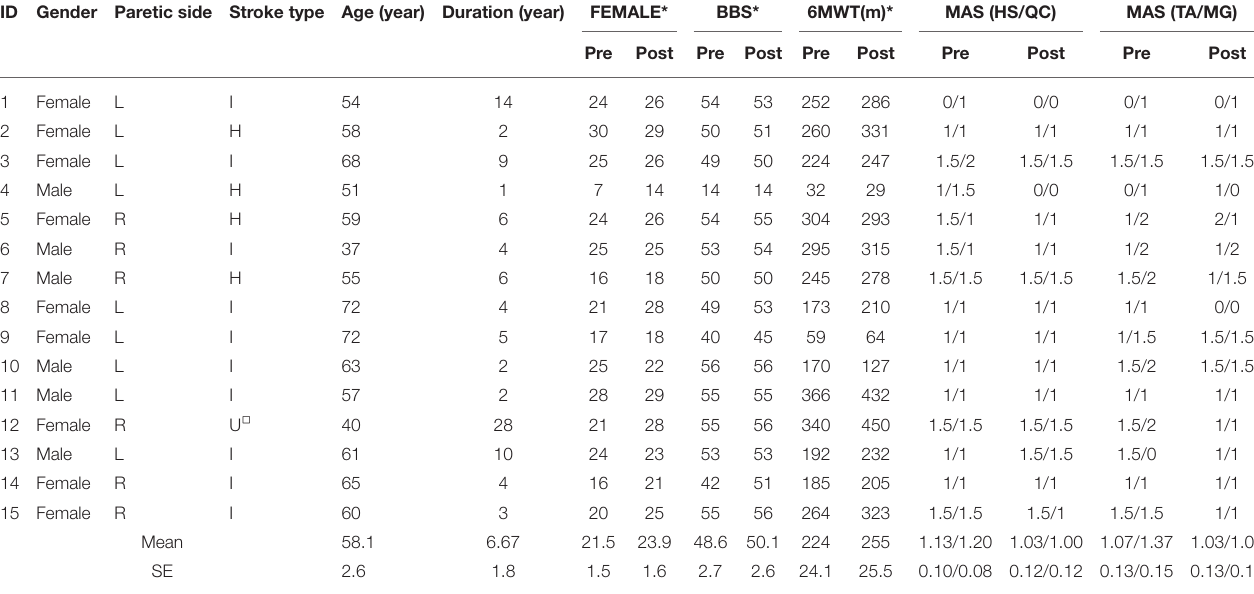
TABLE 1 | Clinical information of subjects.